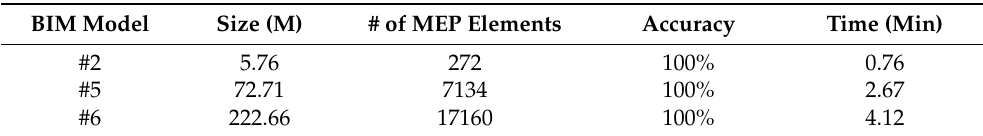
Figure 19. Directed representative graph of model 2#. Table 3. Comparison of the extracting effect of directed representative graphs among models #2, #5, and